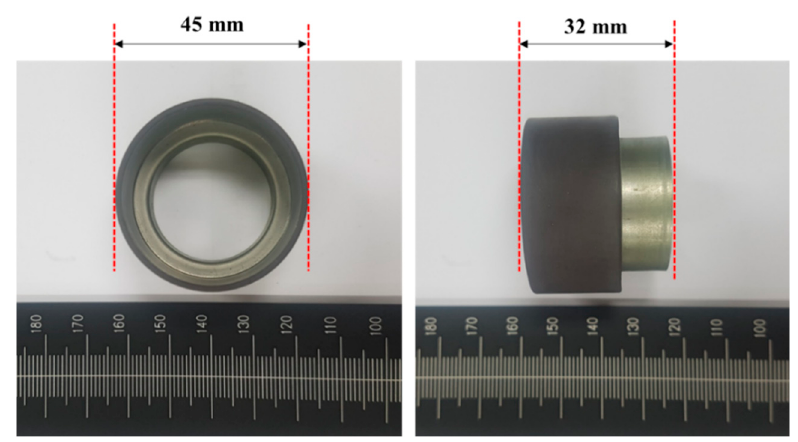
Figure 3. Photographs of the fabricated MTE. Figure 2. MTE design for finite element analysis. Table 1. Magnetic flux of the MTE according to distance between angle and torque tracks.